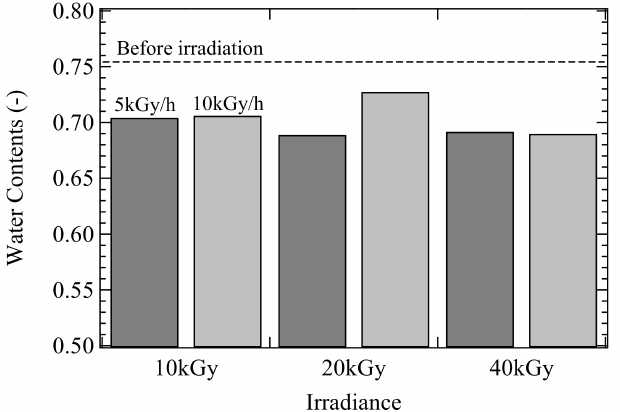
Figure 1. Water contents of poly(vinyl alcohol) PVA cast-drying (CD) on freeze-thawed (FT) hybrid gels before and after gamma ray irradiation. The broken line shows the water content of the gel before gamma irradiation.